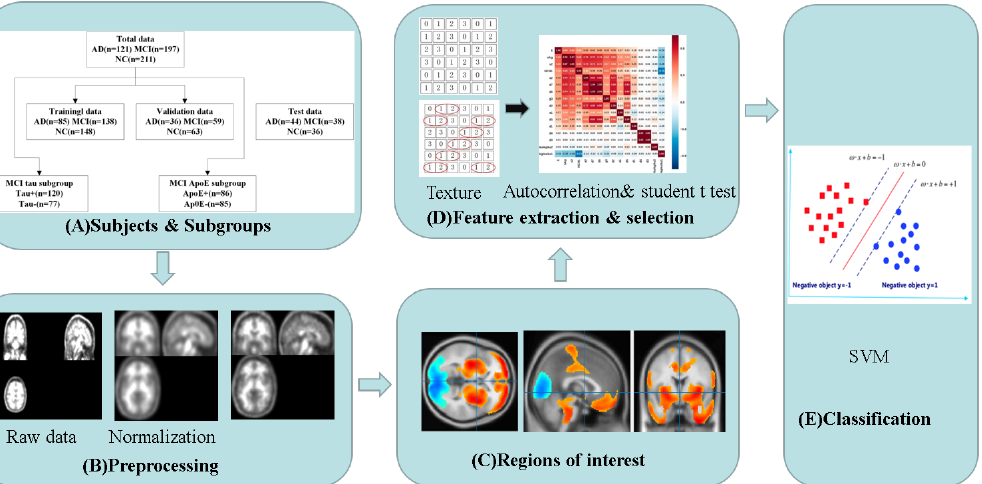
Figure 1. The main workflow for Tau PET radiomics analysis comprised five sections: subjects, subgroups, preprocessing, regions of interest and classification. SVM: support vector machine.